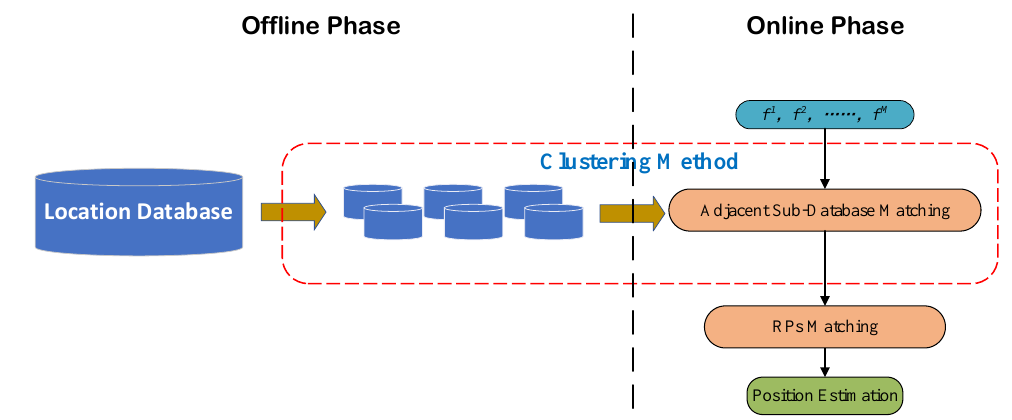
Figure 4. The RPs matching process based on clustering